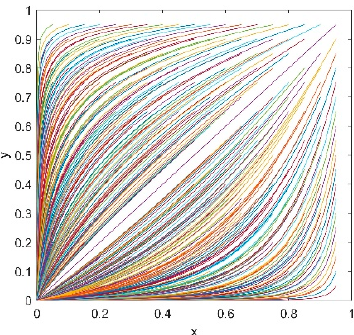
Figure 14. Evolution of the integrated strategy in Case 4.